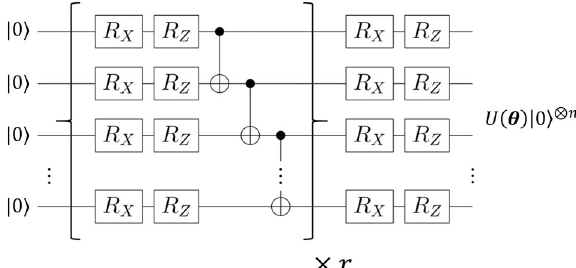
Fig. 2 An example of a parameterized quantum circuit used as an ansatz in VQAs. The circuit parameters θ ¼ ½ θ 1 ; (cid:2)(cid:2)(cid:2) ; θ D (cid:3) > 2 R D with D = 2 n ( r + 1) elements are individually allocated as each rotation angle of Pauli rotation gates R X ð θ i Þ : ¼ e (cid:5) i θ i X and R Z ð θ j Þ : ¼ e (cid:5) i θ j Z . The part of the circuit surrounded by the braces is repeated r times, where the repeated parts may have different